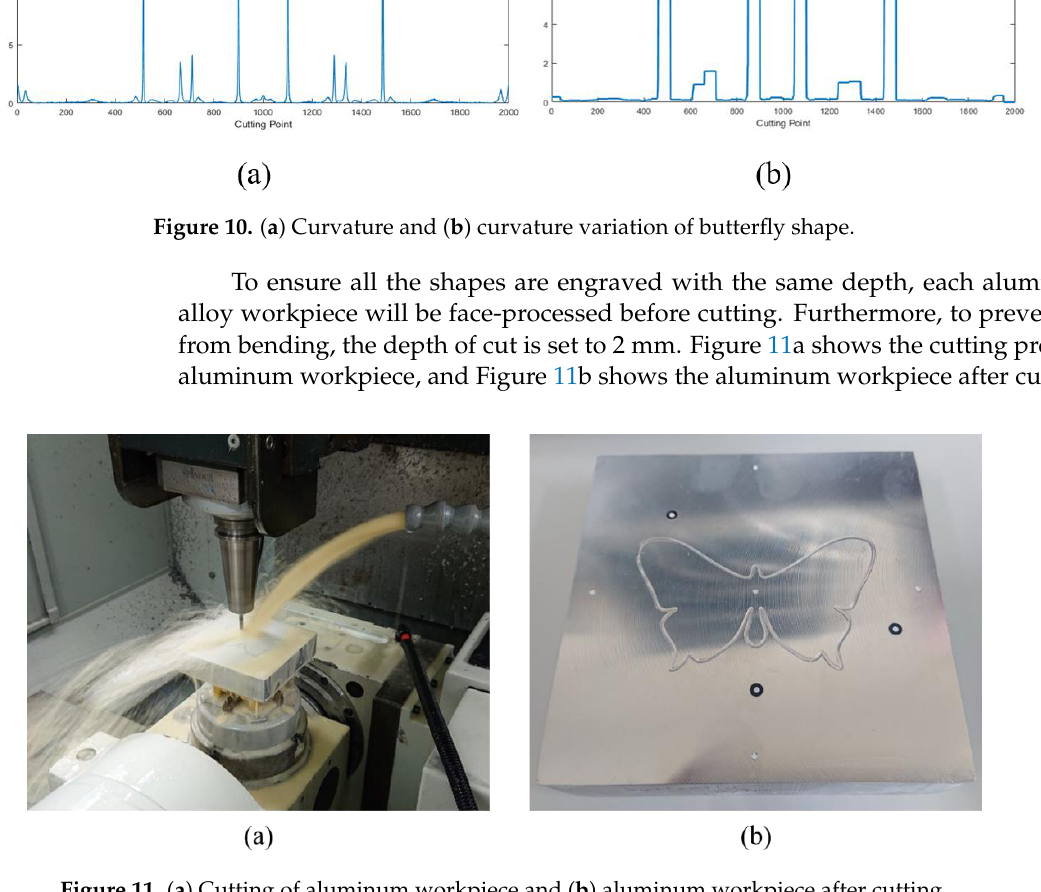
Figure 11. ( a ) Cutting of aluminum workpiece and ( b ) aluminum workpiece after cutting.